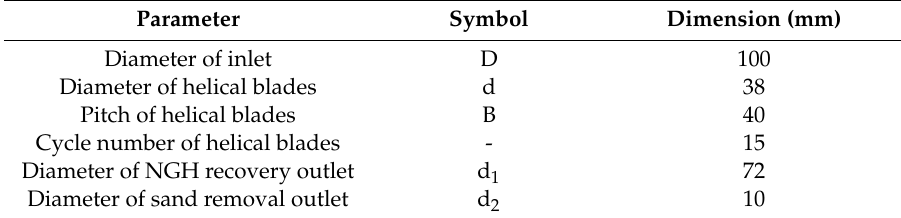
Table 1. Structural parameters of the spiral